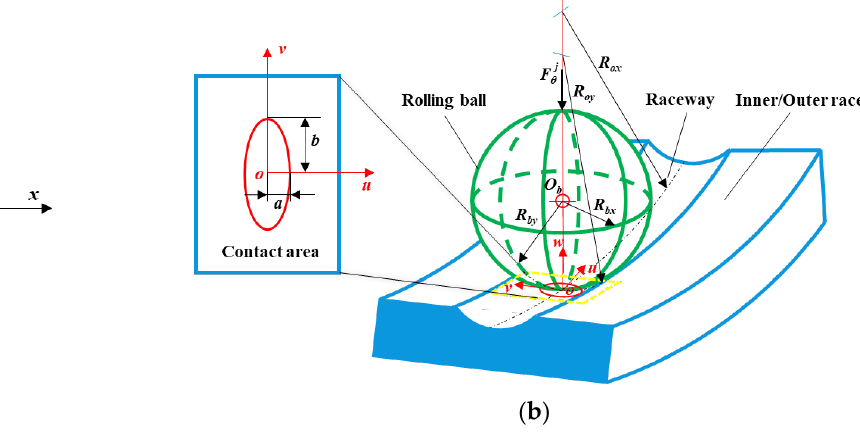
Figure 5. Schematic diagram of the deflection positional relationship ( a ) and point contact diagram ( b ) .